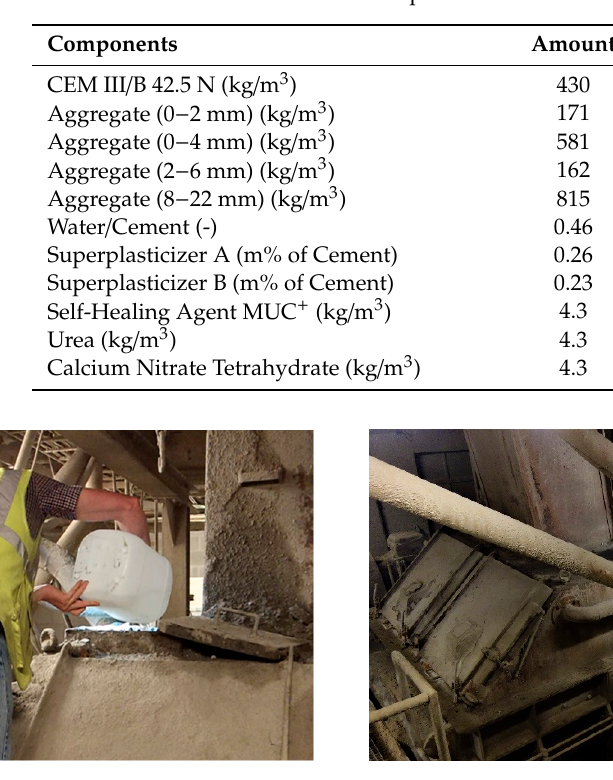
Table 1. Concrete composition.